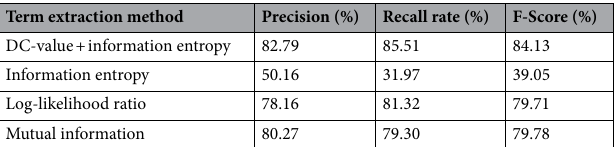
Table 5. Performance comparison among the